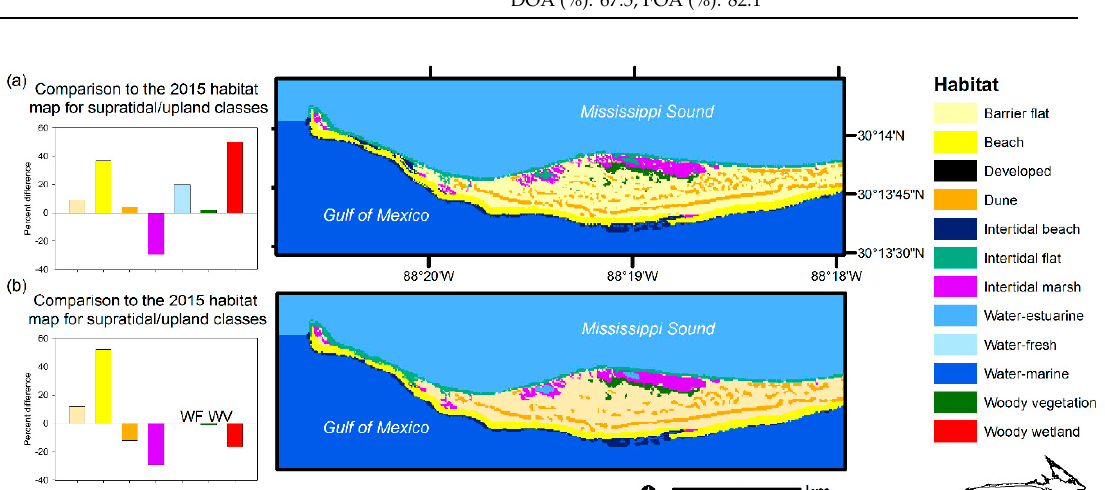
Figure 9. Final habitat model prediction maps for the barrier island for Dauphin Island, Alabama, USA. ( a ) Final contemporary model (i.e., 2015). ( b ) Final hindcast model (i.e., 2007 for most of the island and 2002 to for the northeast portion of the island).